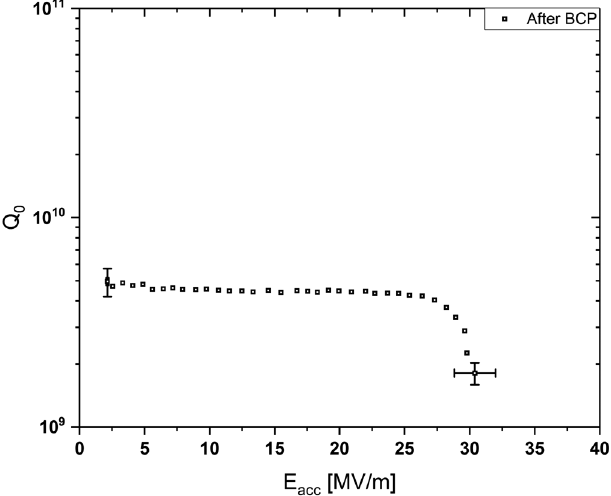
FIG. 6. FH3A test results at T b ¼ 2 . 0 K and at T b ¼ 2 . 0 K, T b ¼ 1 . 8 K, and T b ¼ 1 . 6 K after 120 °C baking. Note the characteristic high-field degradation before 120 °C baking. Q 0 dropped after multiple quenches at 1.6 K as shown by the data measured while lowering the field after quench, indicated by the arrow.